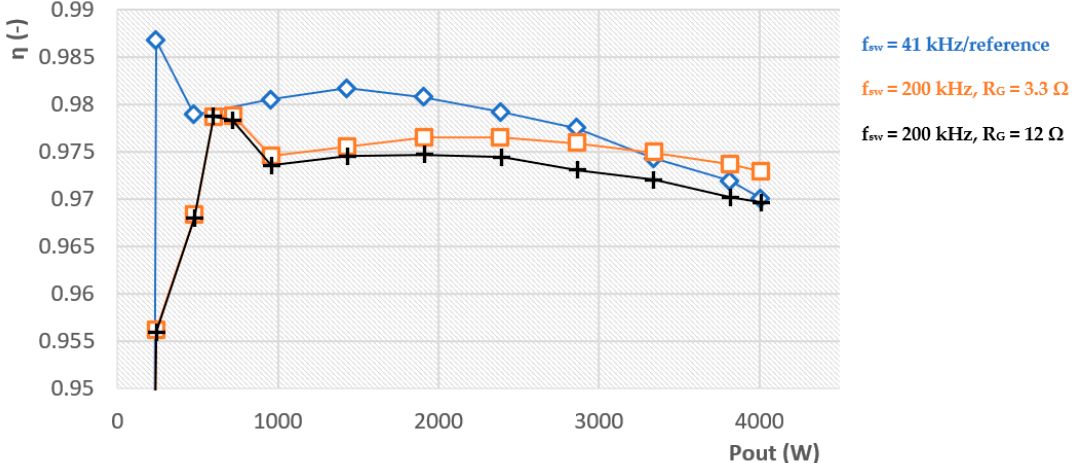
Figure 13. Efficiency characteristic of PFC converter equipped with IMZA65R072M1 SiC transistor in dependency on the output power and switching frequency (blue line—referenced non-optimized solution).